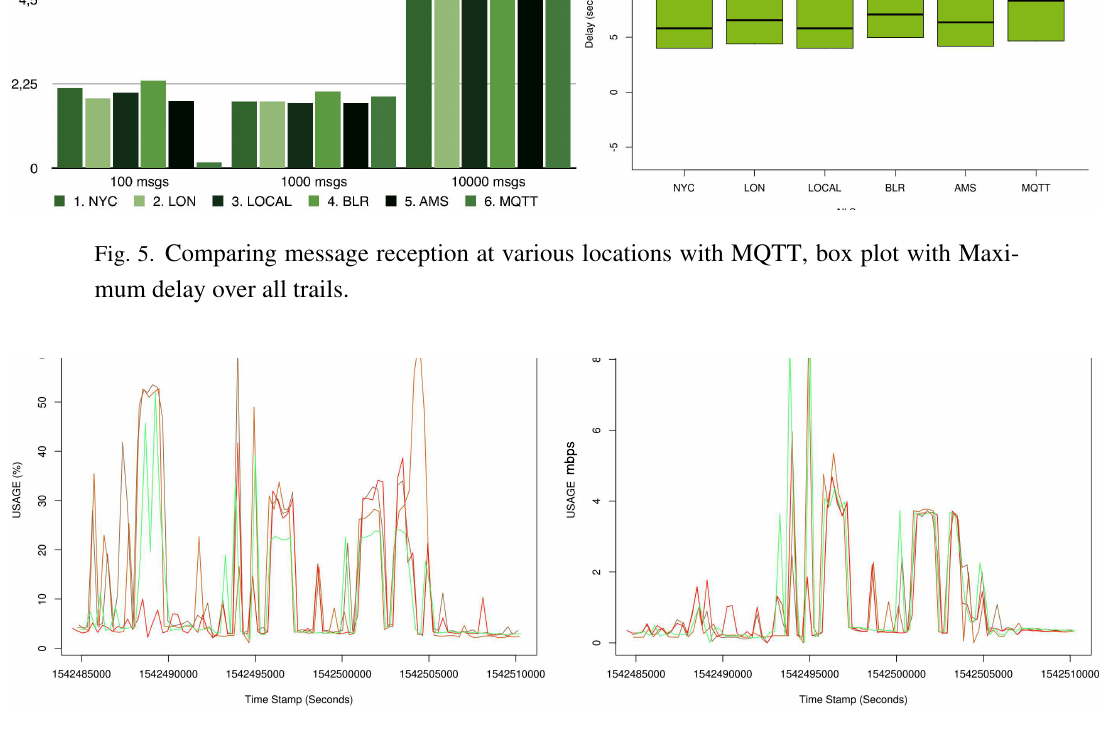
Fig. 6. Resource usage for cloud servers with Tendermint